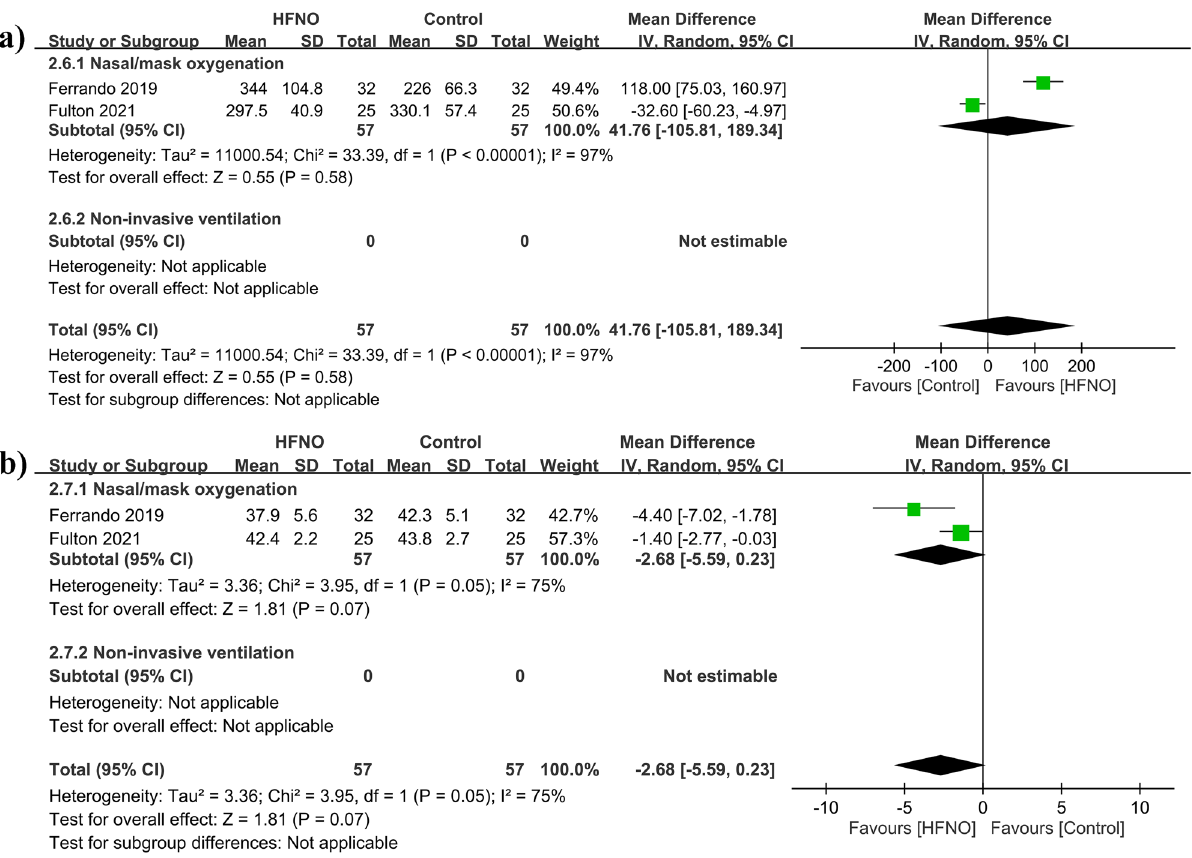
Figure 6. Forest plot comparing ( a ) PaO 2 /FiO 2 ratio and ( b ) PaCO 2 level between HFNO and control groups. HFNO, high-flow nasal oxygenation; IV, inverse variance; CI, confidence